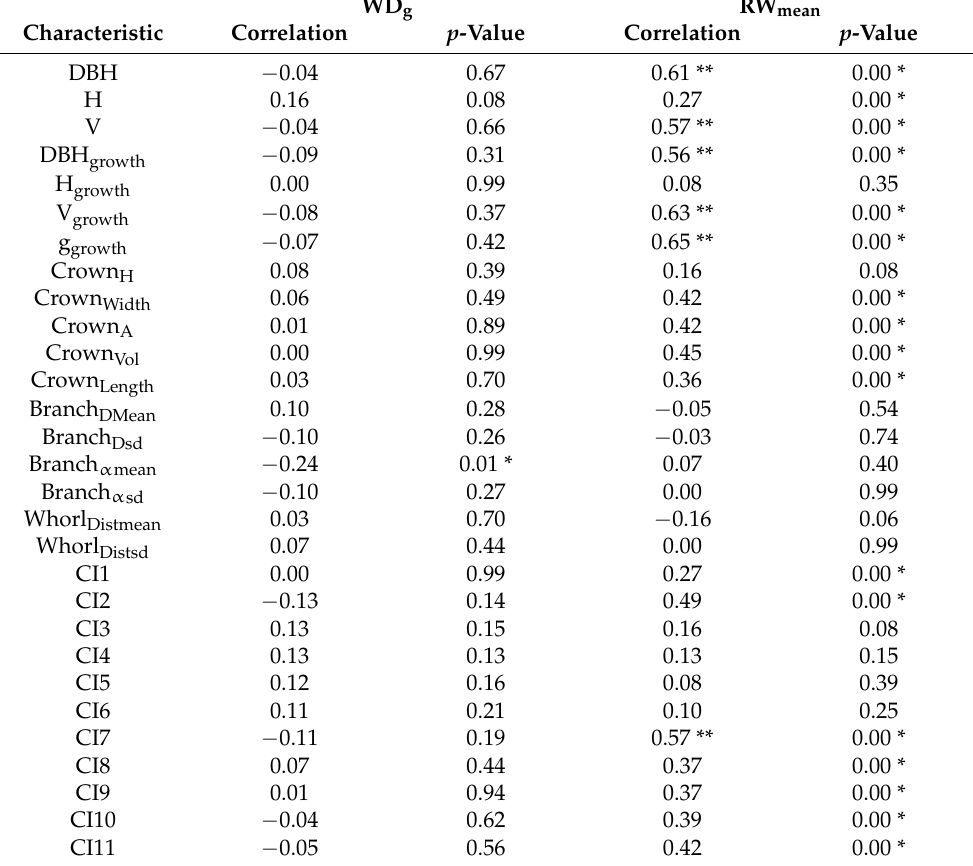
Table 5. Pearson’s correlation coefficients between ring basal area weighted mean wood density (WD g ), mean ring width (RW mean ) and tree structural characteristics (refer to Table 2 for descrip- tions). * Indicates a statistical significance (i.e., p -value ≤ 0.05). ** Indicates a strong correlation (i.e., correlation > 0.5). WD g RW mean Characteristic Correlation p